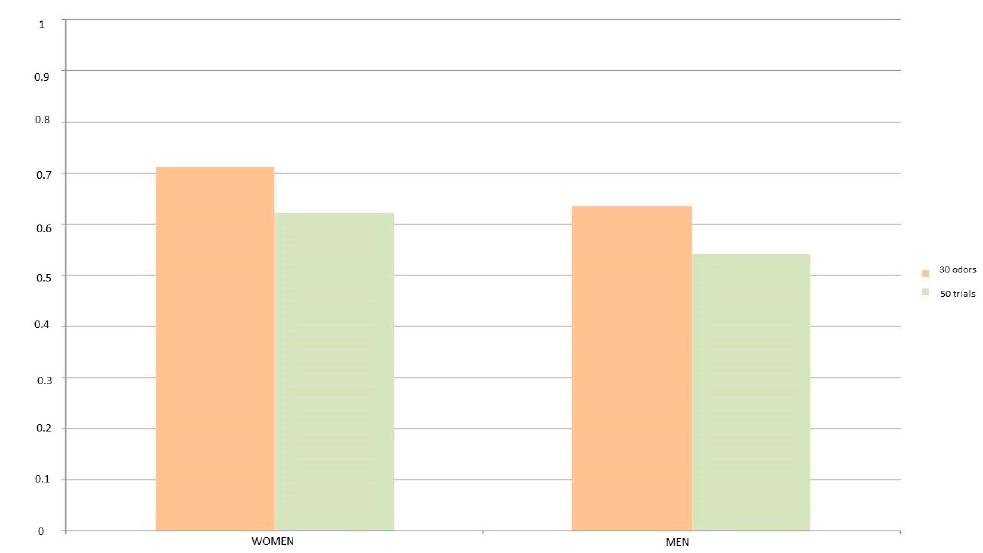
Figure 4. Average of recognized odors according to gender.